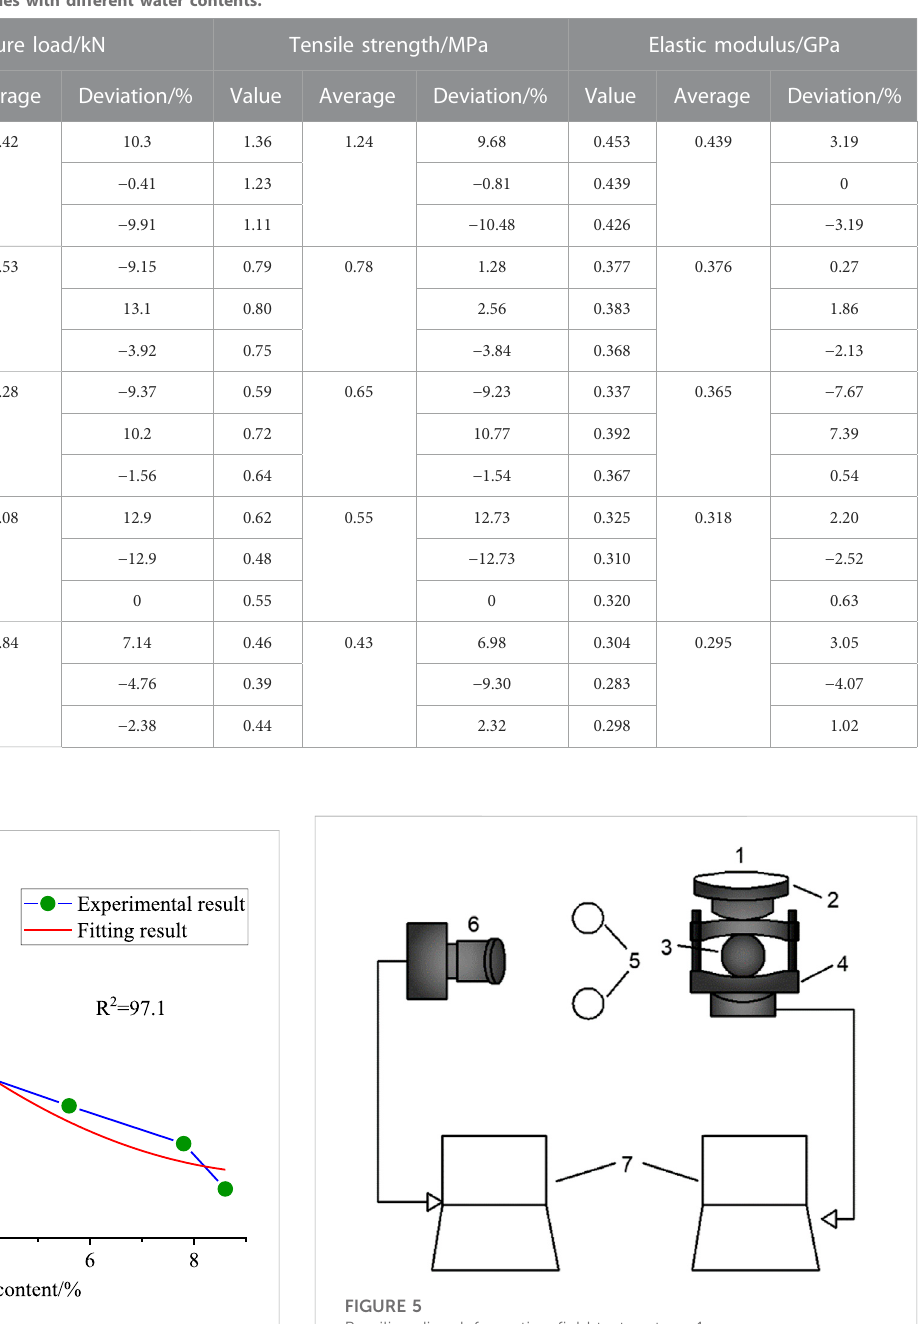
TABLE 2 Mechanical parameters of samples with different water contents.